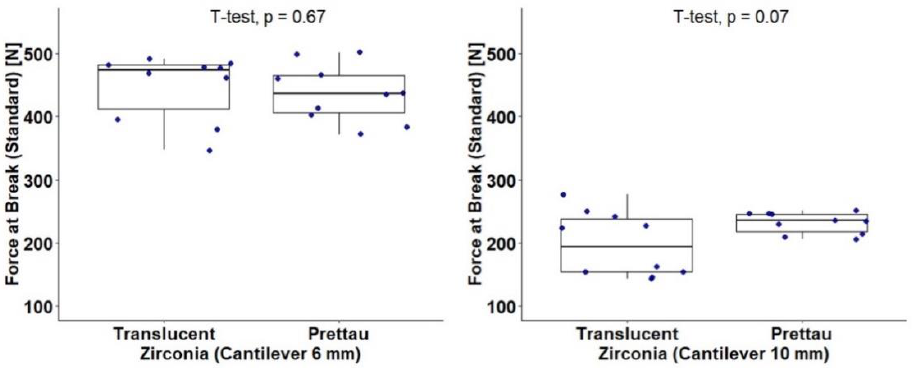
Figure 5. Force at break (standard) (N) according to type of zirconia stratified by cantilever length (6 mm and 10 mm).